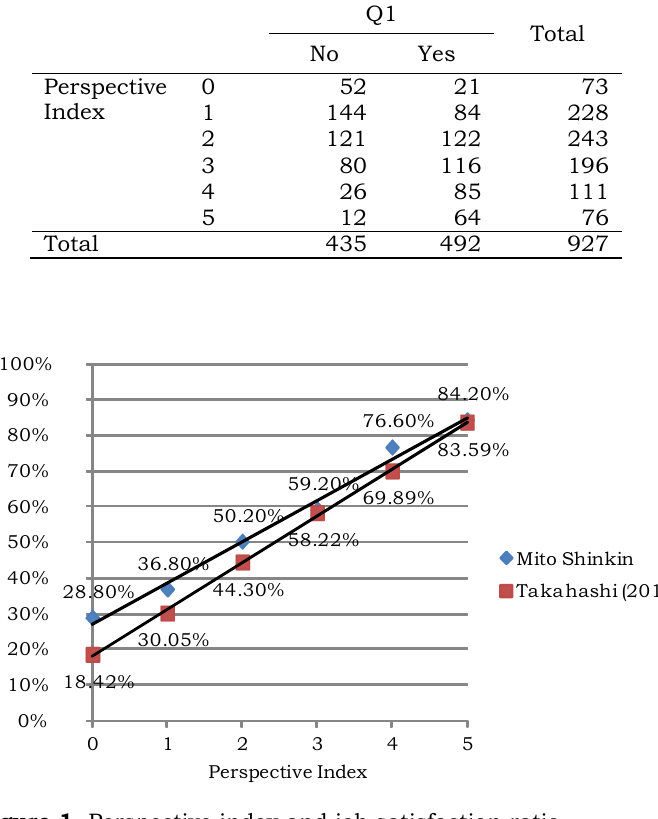
Figure 1. Perspective index and job satisfaction